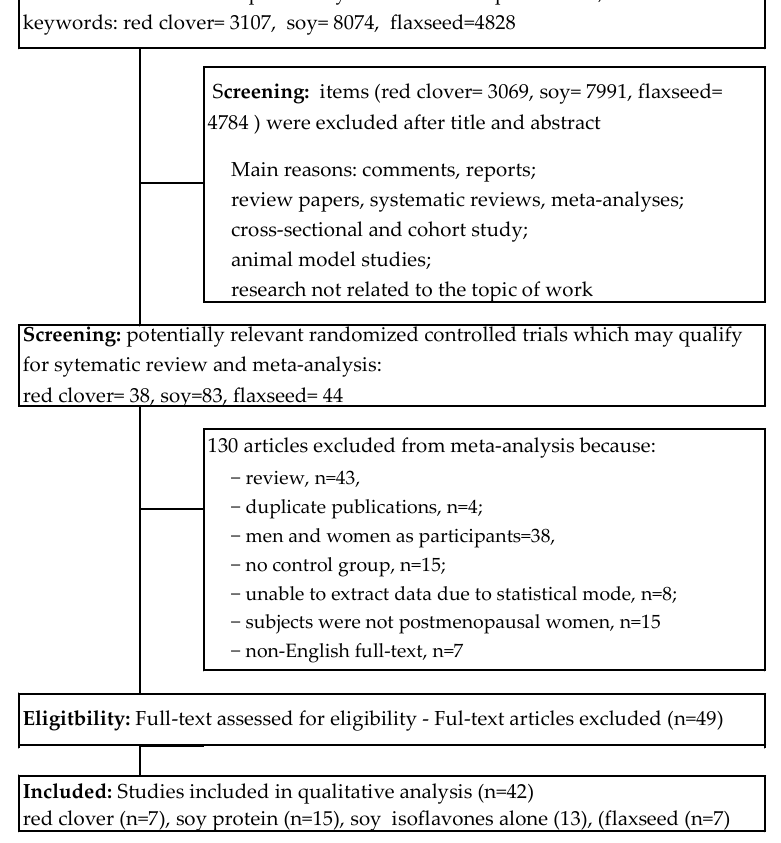
Figure 1. Flowchart of the selection procedure for studies included in the current review and meta- analysis.